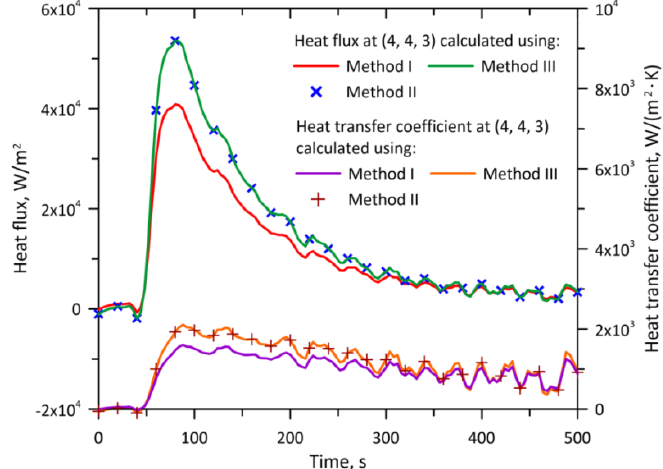
Figure 7. Time variations of heat flux and heat transfer coefficient on the cooled surface when dividing the thickness of the plate into three control volumes.